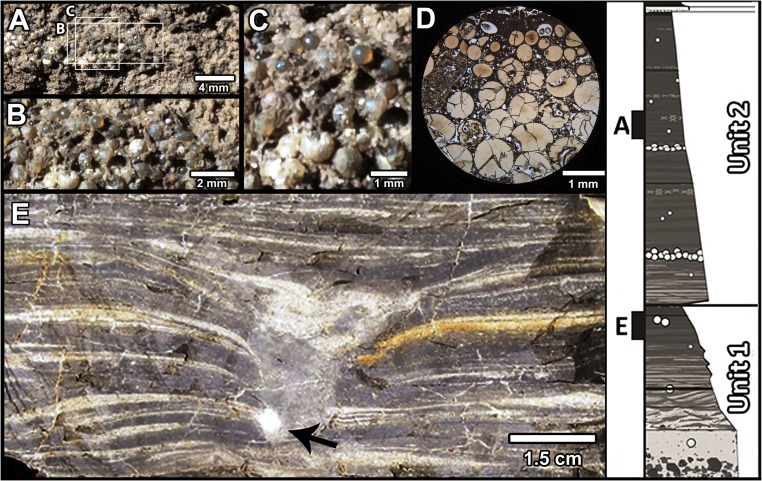
In situ ejecta at Tanis. (A–C) Field photos of an ejecta lens in situ. (D) Petrographic thin section of a spherule lens (FAU.DGS.ND.161.88.T). (E) Cross-section of down-warped “microcrater” caused by incoming ejecta, with arrow pointing to spherule (FAU.DGS.ND.161.65.T). (Right) Region of origin for the items pictured.